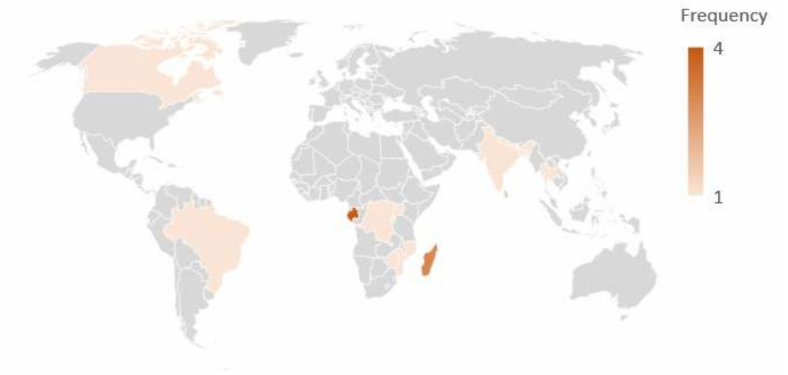
Figure 3. Location of study sites by